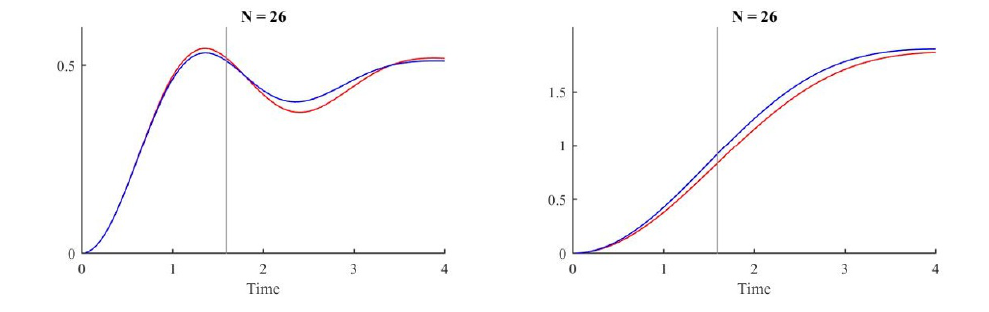
Figure 15 . We compare the expectation value of hf 1 ( t ) ; 2 (0) g 2 i (left) and (cid:0)h [ S 1 ( t ) ; S 2 (0)] 2 i (right) in the thermal state (blue) and pure state (red). The scrambling time is designated by the vertical line.